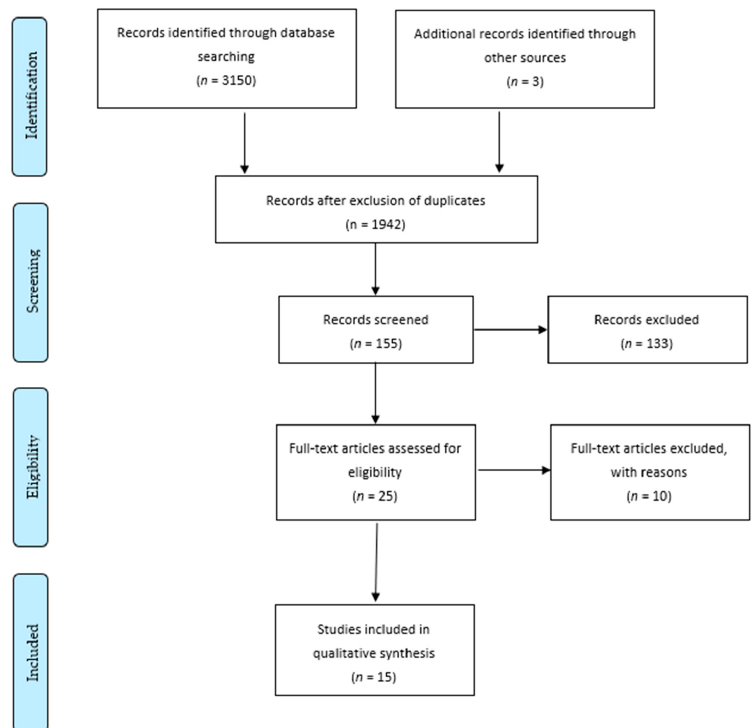
Figure 1. PRISMA flow diagram.